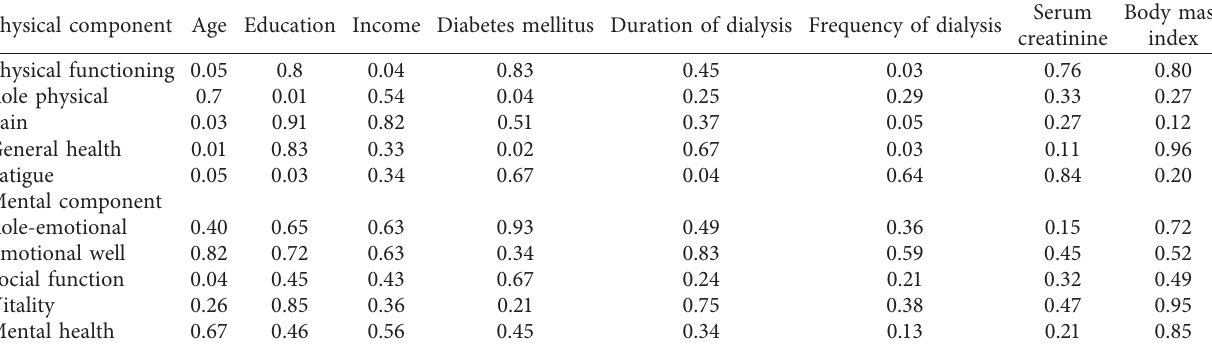
Table 4: Factors of QoL and relationship with demographic and clinical